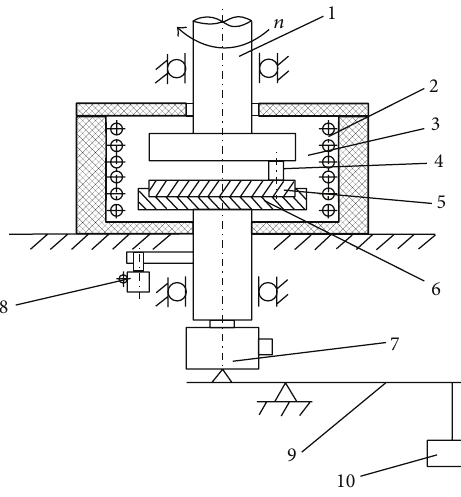
Figure 2: Schematic diagram of test